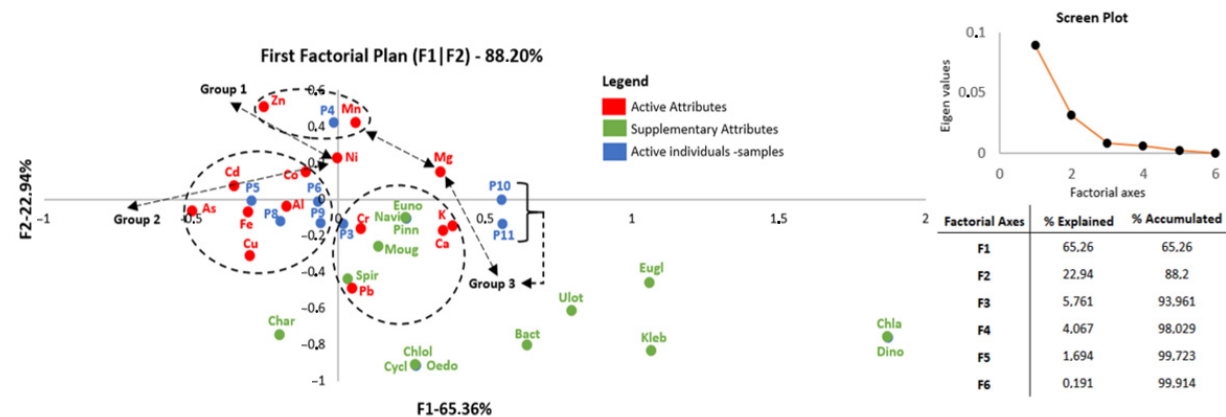
Figure 7. Factorial correspondence analysis output between abiotic and biotic features of the ecosystem. Moug— Mougeotia ; Ulot— Ulothrix ; Spir— Spirogyra ; Kleb— Klebsormidium ; Eugl— Euglena ; Pinn— Pinnularia ; Euno— Eunotia ; Navi— Navicula ; Oedo— Oedogonium ; Chla— Chlamydomonas ; Char— Characium ; Dino— Dinobryon ; Chlol— Chlorella ; Cycl— Cyclotella ; Bact—